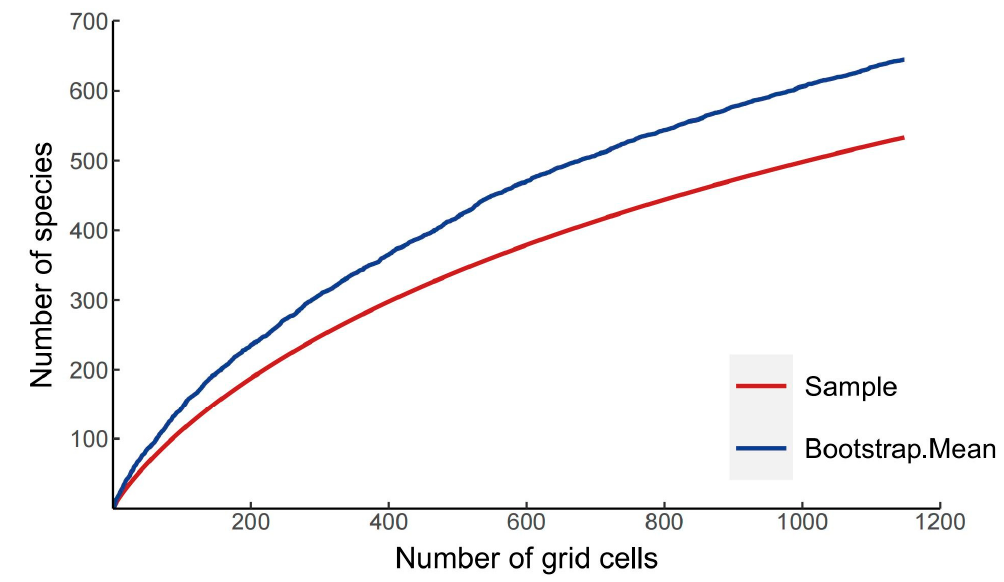
Figure 1. Species accumulation curves for Panorpidae based on bootstrap mean values.